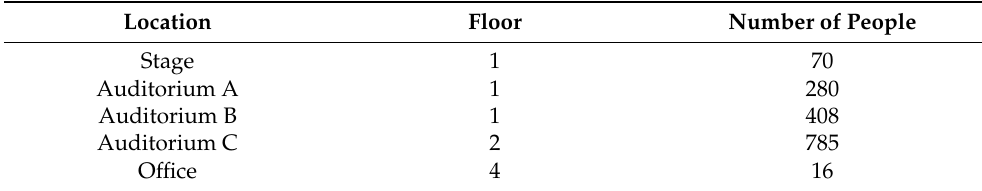
Table 4. Distribution of the number of people on each